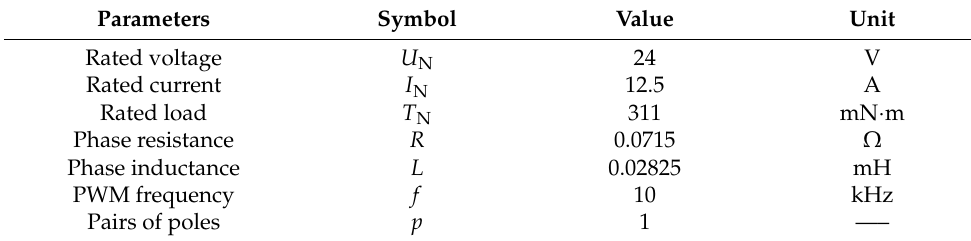
Figure 5. Overall control structure of BLDCM. Table 2. BLDCM parameters.